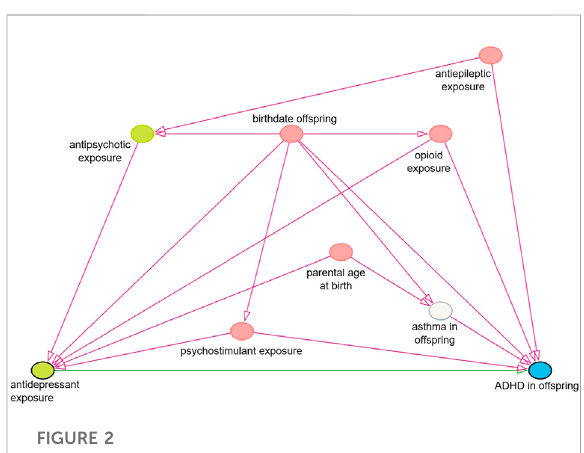
FIGURE 2 Simpli fi ed causal diagram showing causal associations between relevant variables. This diagram represents the associations relevant for the chosen minimal suf fi cient adjustment set for estimating the effect of in utero antidepressant exposure on therisk ofADHDin offspring. This adjustment set was chosen as it was the smallest out of four sets and consists of the fi ve pink nodes in this